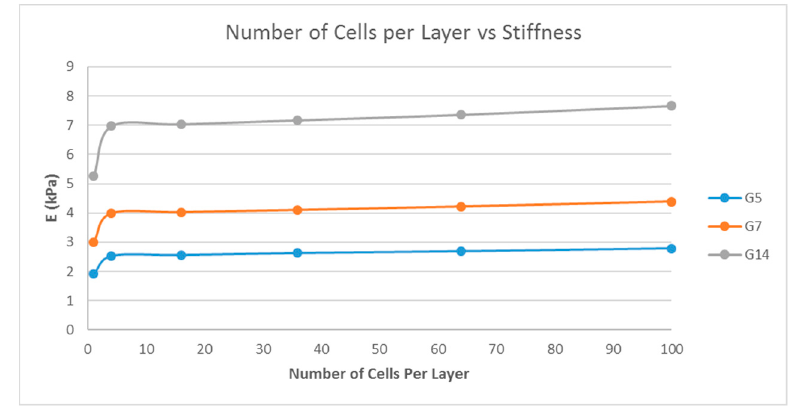
Figure 5. Effect of the number of unit cells per layer on the stiffness of the structure with a fixed fiber width ( d = 80 μ m), porosity (=80%), and unit cell pore side length ( p = 200 μ m) for G5, G7, and G14.